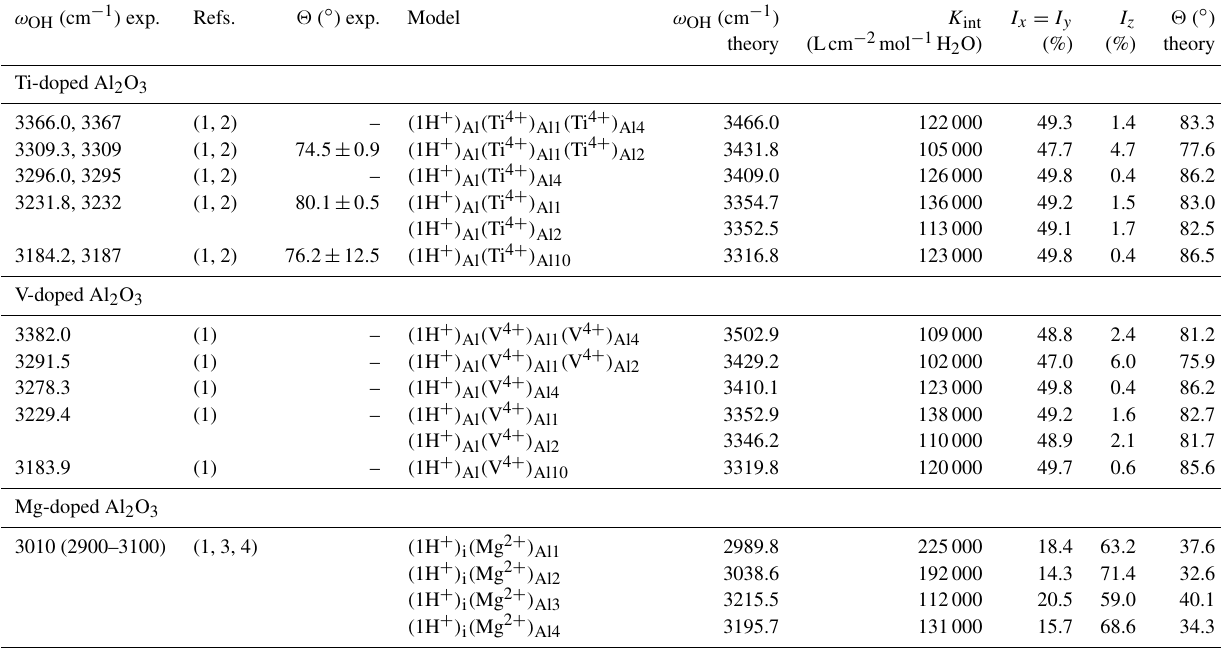
Table 2. Experimental and theoretical properties of OH-stretching bands in doped corundum samples. The I x , I y and I z correspond to relative absorption intensities along Cartesian directions, with the z direction being parallel to [001]. The (cid:50) angle between the OH absorber and the [001] direction is determined from the spectroscopic properties. ω OH (cm − 1 ) exp.